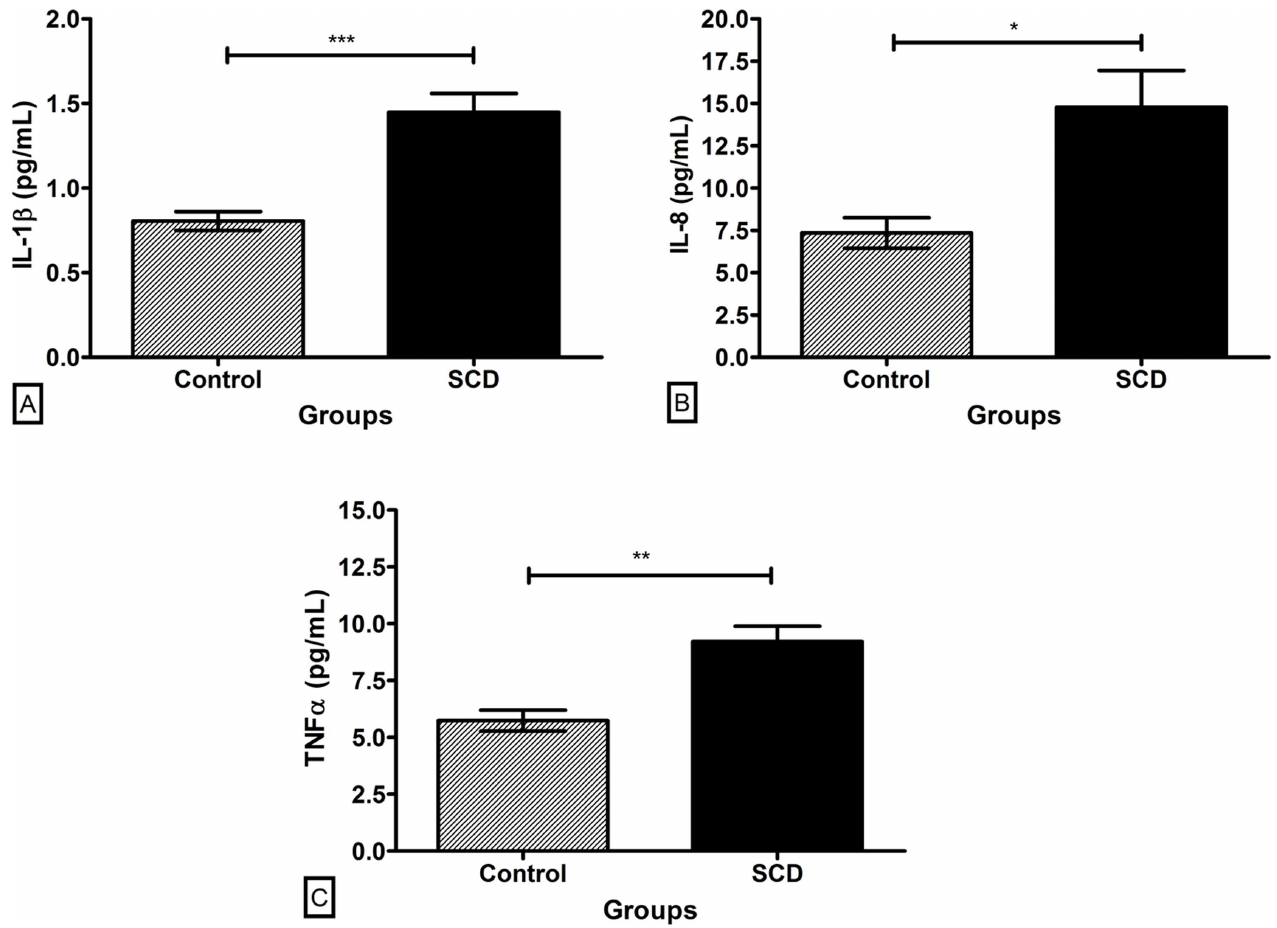
Fig 5. Plasma levels of the proinflammatory cytokines in the control and SCD groups. (A) IL-1 β . (B) IL-8. (C) TNF- α . Data expressed in mean ± standard error of the mean. Statistical analysis: Student t-test. * p < 0.05. ** p < 0.01. *** p < 0.001.